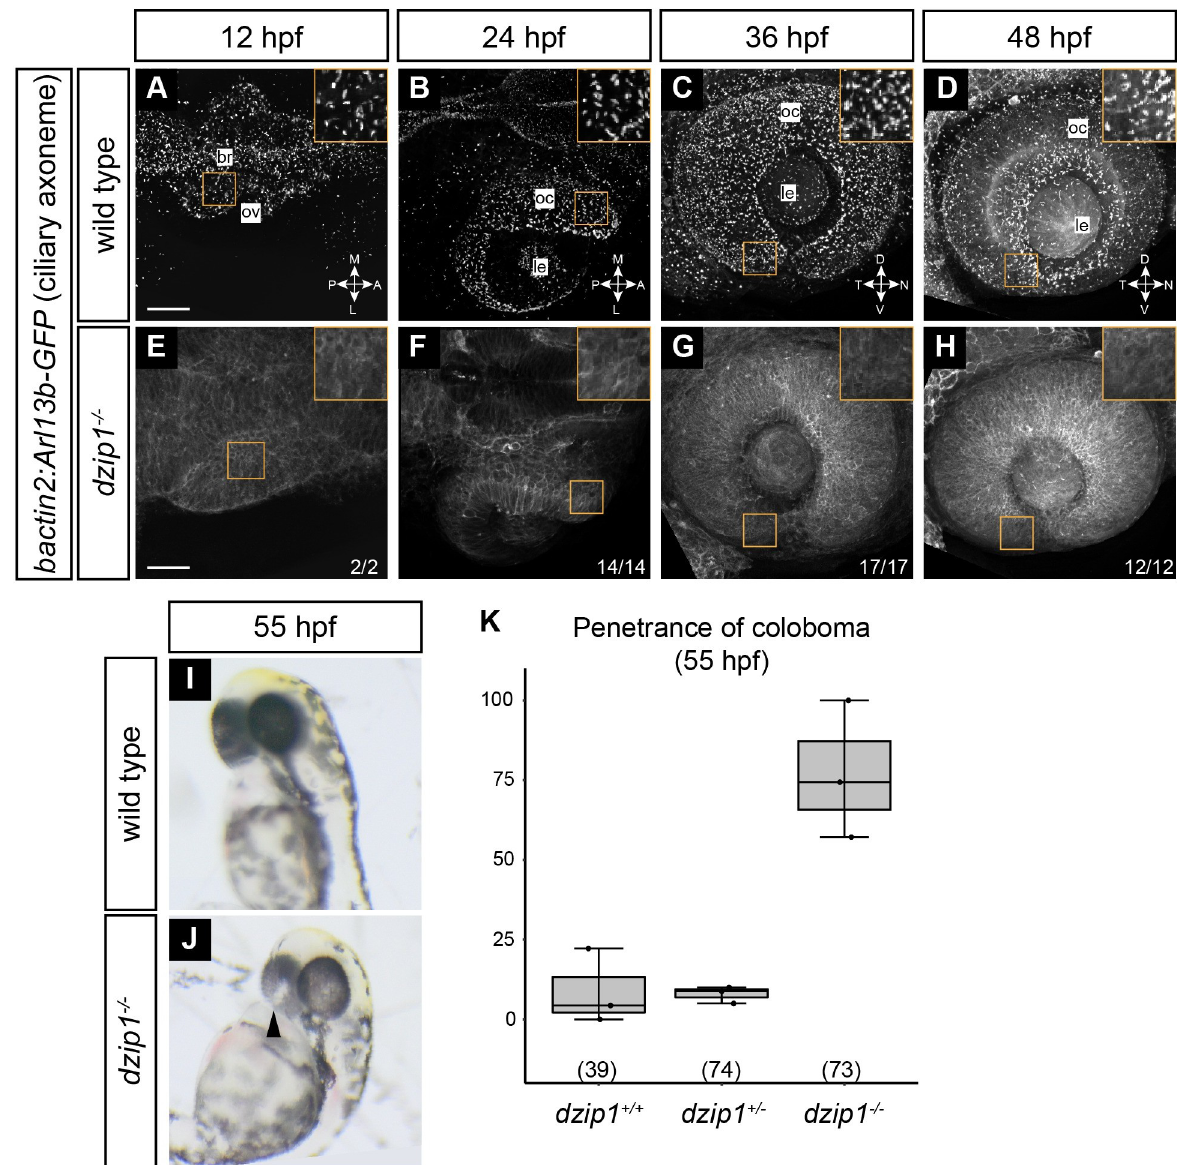
Fig 1. dzip1 mutants have no cilia in the eye and display coloboma. (A-H) Wild type (A-D) and dzip1 ts294e mutants (E-H) visualized for cilia ( Tg (bactin2 : Arl13b-GFP) ) at 12 hpf (A, E), 24 hpf (B, F), 36 hpf (C, G), and 48 hpf (D, H). A, B, E, and F are dorsal views of 3-dimensional renderings; while C, D, G, and H are lateral views of 3-dimensional renderings. (A-D) GFP-positive cilia are visualized as distinct puncta present throughout the lens, eye, and embryo midline (A, magenta arrowhead ). (E-H) Cilia are completely absent in dzip1 -\- embryos. n (fraction of dzip1 -/- embryos showing complete absence of cilia) is shown at the bottom right of each panel. Insets show zoomed views for each timepoint and genotype. (I-K) dzip1 -/- mutants display coloboma. (I) Wildtype embryo at ~55 hpf; the eye is evenly pigmented; there is no coloboma. (J) dzip1 ts294e mutant embryo, ~55 hpf; coloboma is visible as a hypopigmented region at the back of the eye ( arrowhead ). (K) Penetrance of the coloboma phenotype at 55 hpf. n (embryos) for each genotype shown at the base of the graph. Scale bar: 50 μ m. M, medial; L, lateral; A, anterior; P, posterior; D, dorsal; V, ventral; N, nasal; T, temporal; le, lens; oc, optic